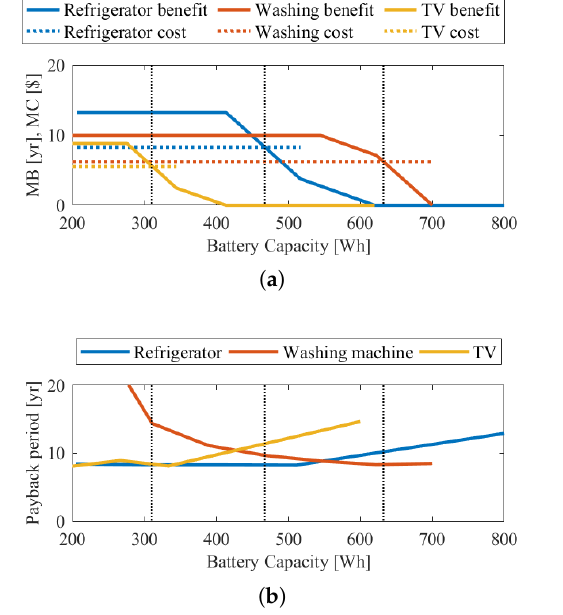
Figure 8. Marginal Rule. ( a ) The marginal benefit of operating for 8 years and marginal cost for installing an additional battery of the 3 home appliances. ( b ) The changes in the payback period for expanding the battery capacity of 3 different home